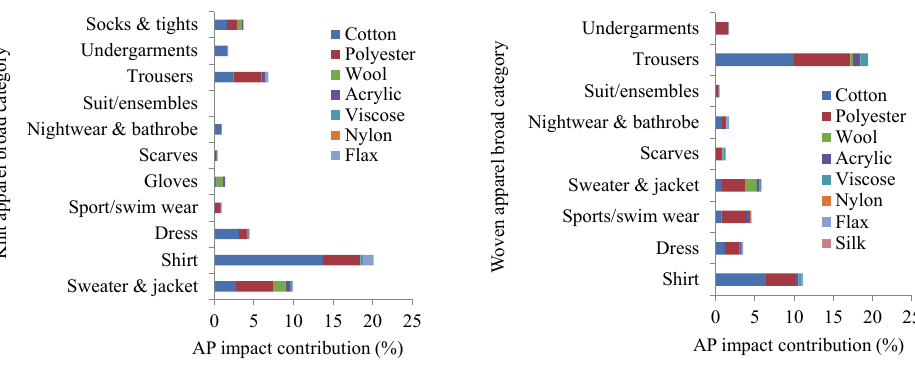
Fig. 15. AP impact contribution of apparel broad categories based on total market